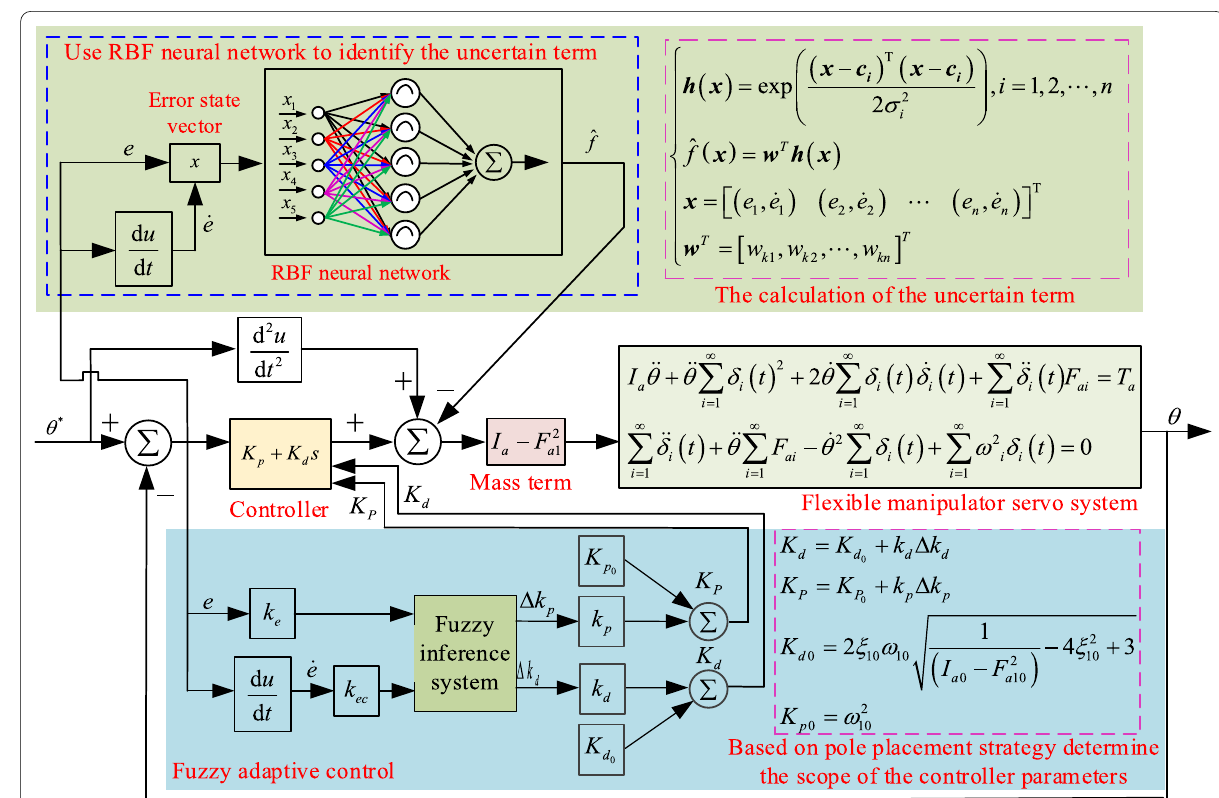
Figure 9 Schematic diagram of the control loop of telescopic flexible manipulators based on fuzzy adjustment and the RBF neural